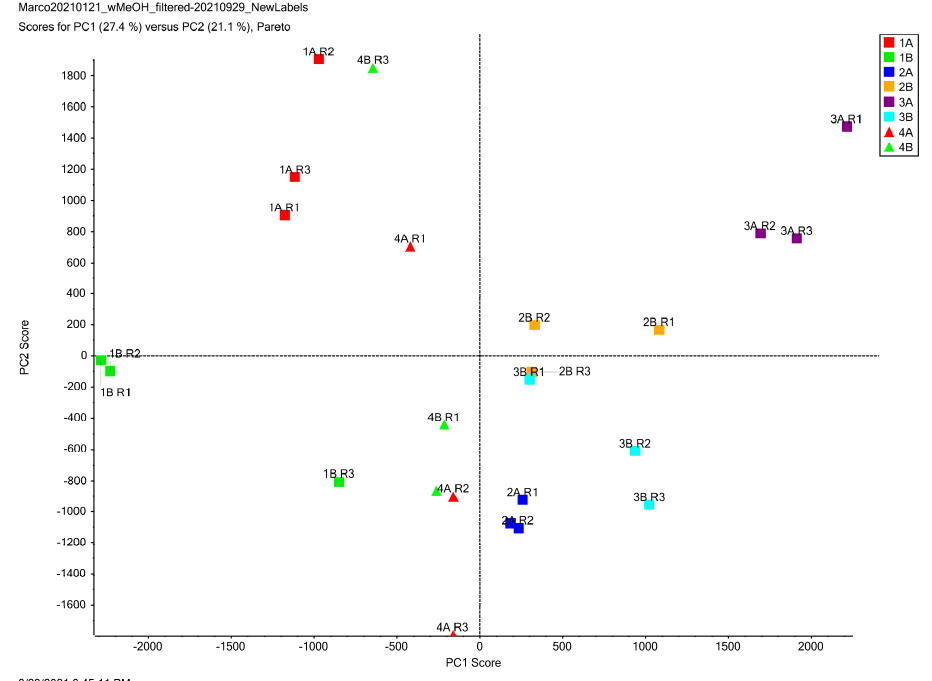
Figure 2. PCA plot from the LC-QTOF-MS Figure S1. Marco20210121_wMeOH_filtered-20210929_NewLabels Scores for PC1 (27.4 %) versus PC2 (21.1 %), Pareto.